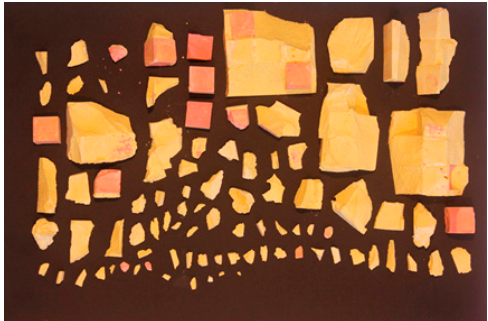
Figure 7. Preparing the crushed particles on a black background for taking images.